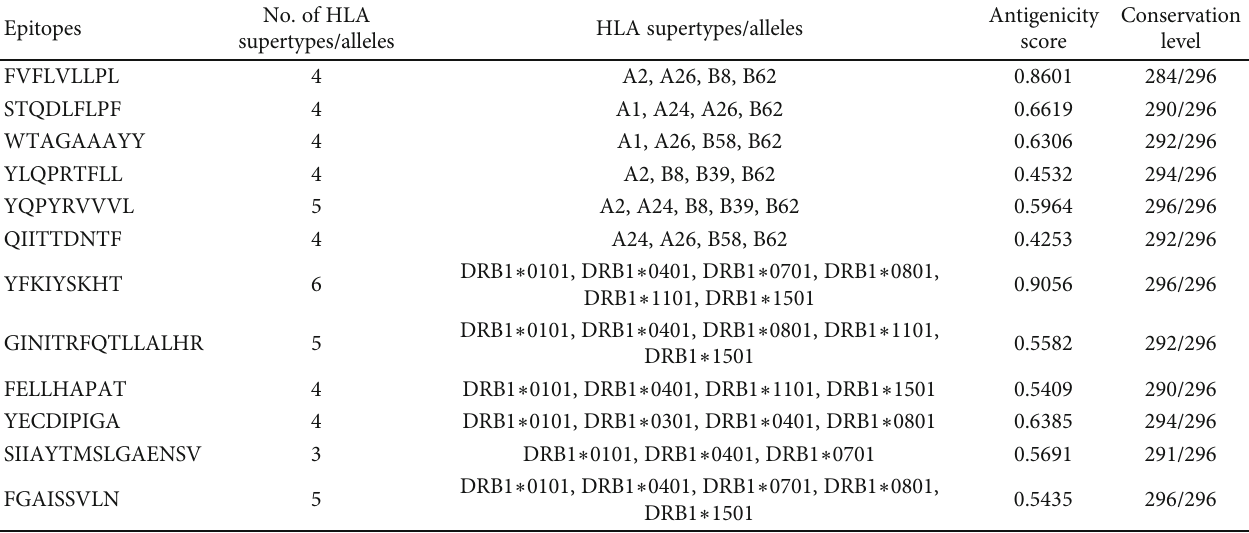
Table 1: List of prioritized epitopes and their putative properties as well as their conservation in 296 spike protein sequences.